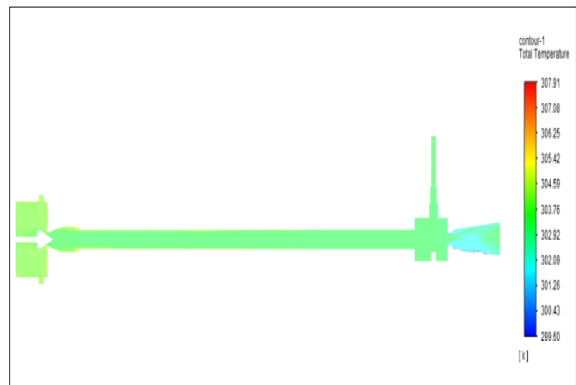
Figure 29. PVC at 8 bar.